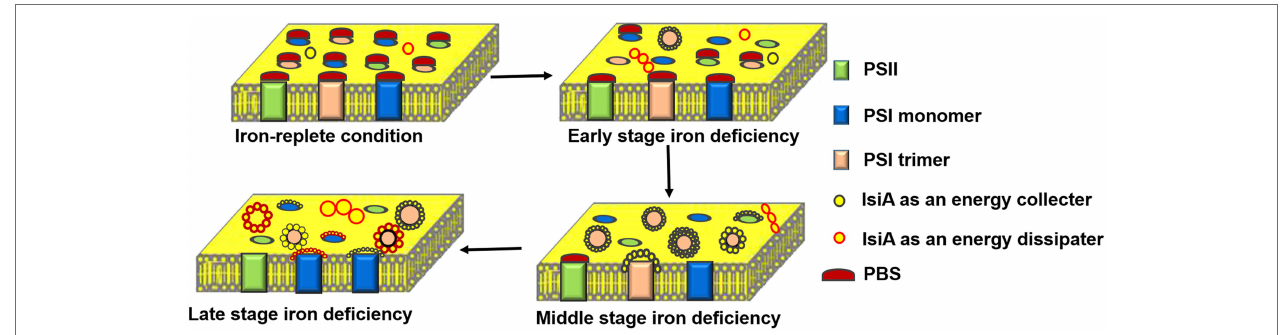
FIGURE 3 | Schematic representation of the dynamic changes in the structure and function of IsiA-containing complexes during a long period of iron deficiency. Under the iron-replete condition, phycobilisome (PBS) acts as a light-harvesting complex for both PSII and PSI. In the early stages of iron deficiency, IsiA forms small aggregates and IsiA 18 -PSI trimers, in which the IsiA proteins serve as energy collectors and efficiently transfer energy to the PSI cores. In the middle stage of iron deficiency, the levels of PSB, PSI, and PSII all decline, with PSB still serving PSII. An IsiA-PSI low fluorescence supercomplex (ILFS) is formed, in which IsiA acts an energy collector. In the late stage of iron deficiency, the IsiA-PSI high fluorescence supercomplex (IHFS) and plentiful IsiA aggregates are formed. The IsiA proteins serve as an energy dissipater, providing photoprotection for the entire photosynthetic apparatus, especially